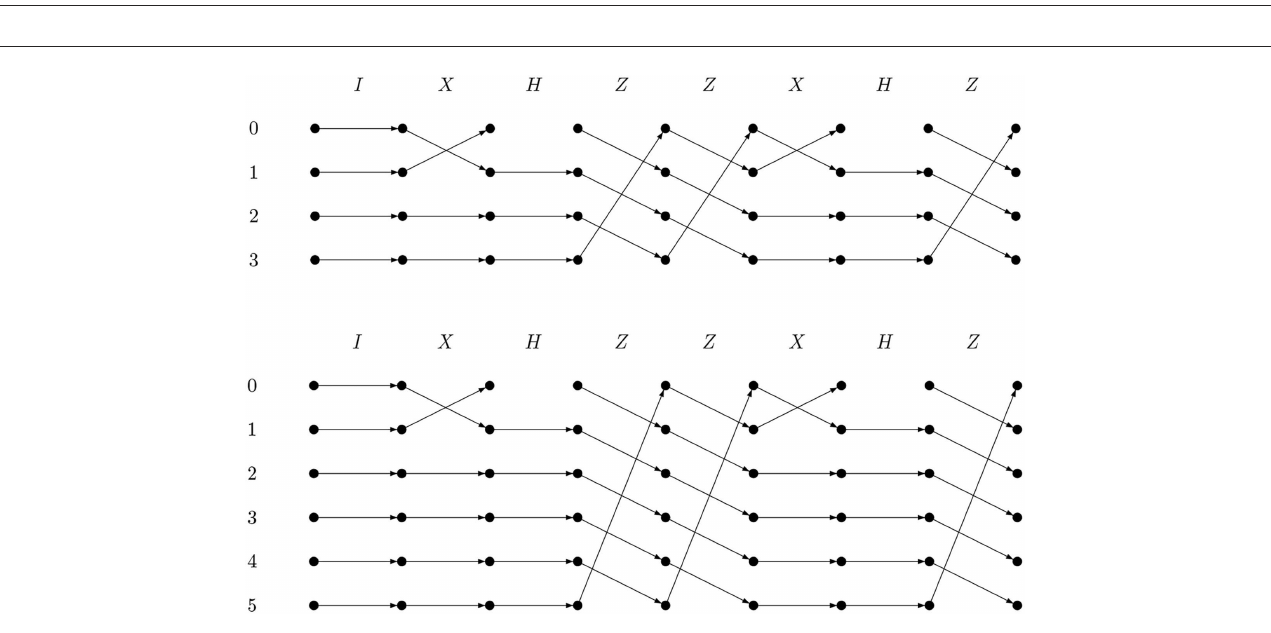
FIGURE4 Grid induced by the word IXHZZXHZ when n = 2 (top) and n = 3 (bottom)